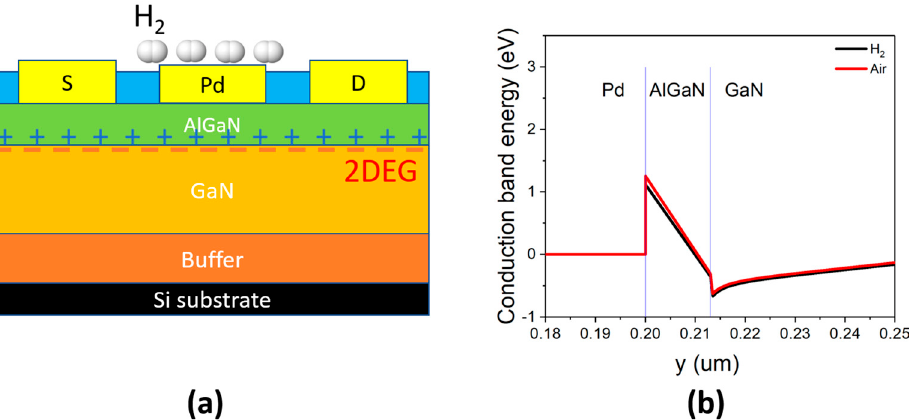
Figure 3. The sensing mechanism of gas sensor based on Pd-AlGaN/GaN HEMT ( a ) and the change of conduction band energy with hydrogen exposure ( b ).